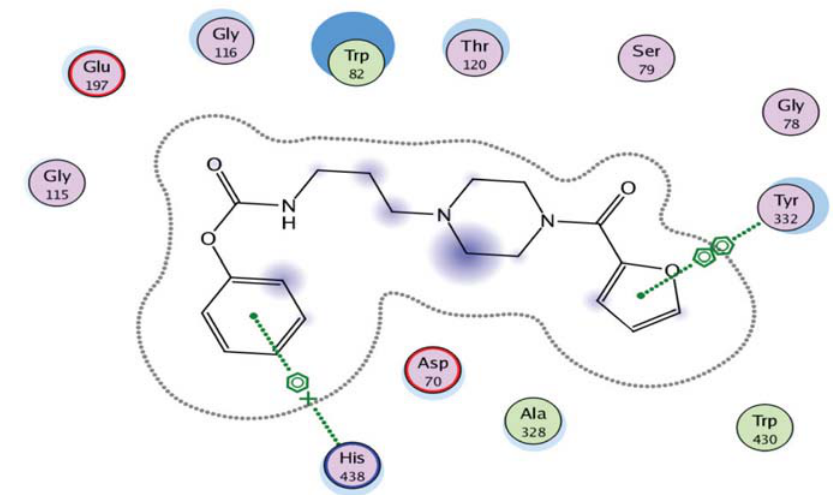
Fig. 6. 2D interacted image of phenyl 3- [ 4-(2-furoyl)-1-piperazinyl ] propylcarbamate ( 12 ) against butyrylcholinesterase.